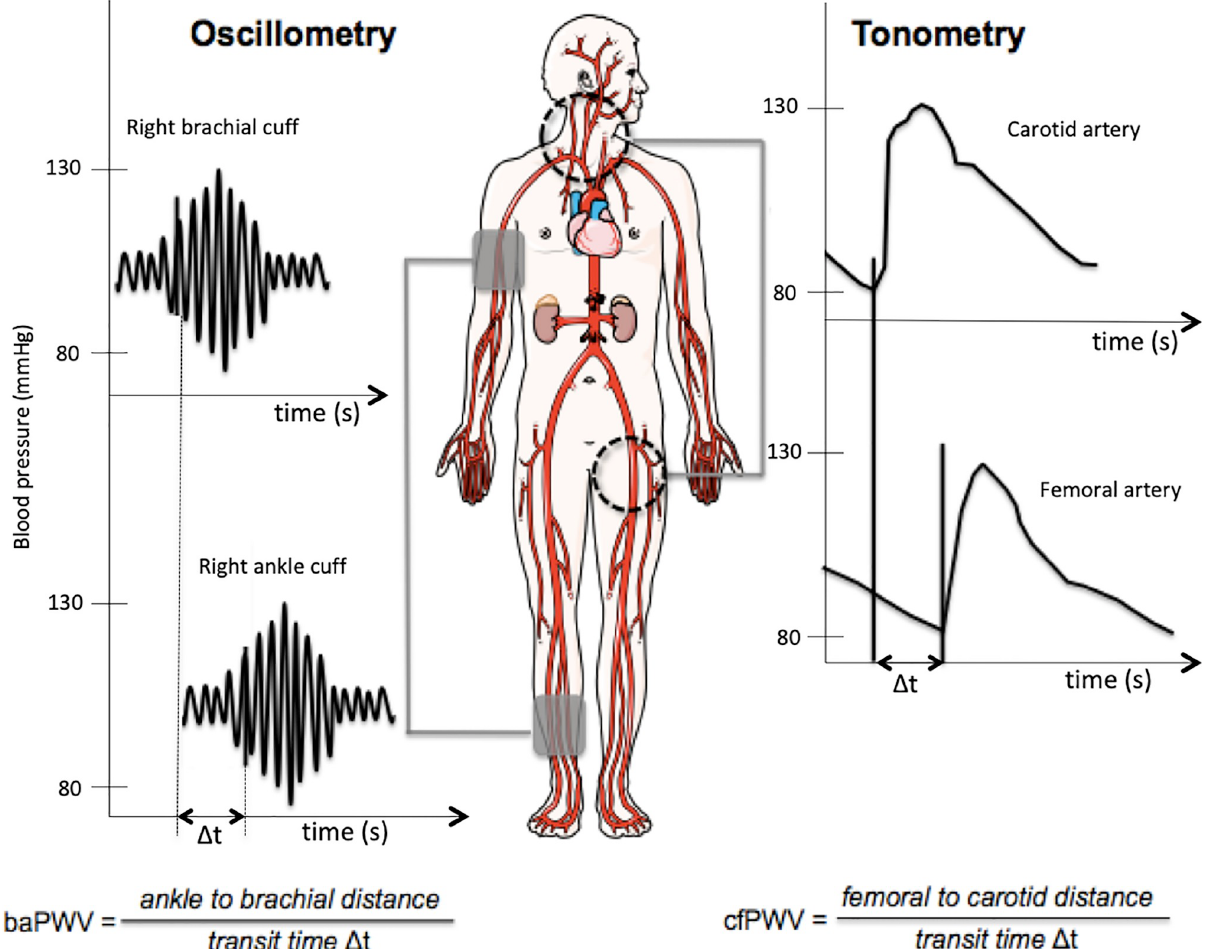
Fig 2. The oscillometric device assesses the brachial-ankle pulse wave velocity (baPWV) through the measurement of the transit time between the brachial artery and tibial artery through the oscillometric amplitude. The determination of the carotid-femoral (cf) PWV results from the following calculation: cfPWV = 0.833 x baPWV -2.333 (m/s). The applanation tonometry device uses the tonometric technique with direct measurement of the cfPWV.